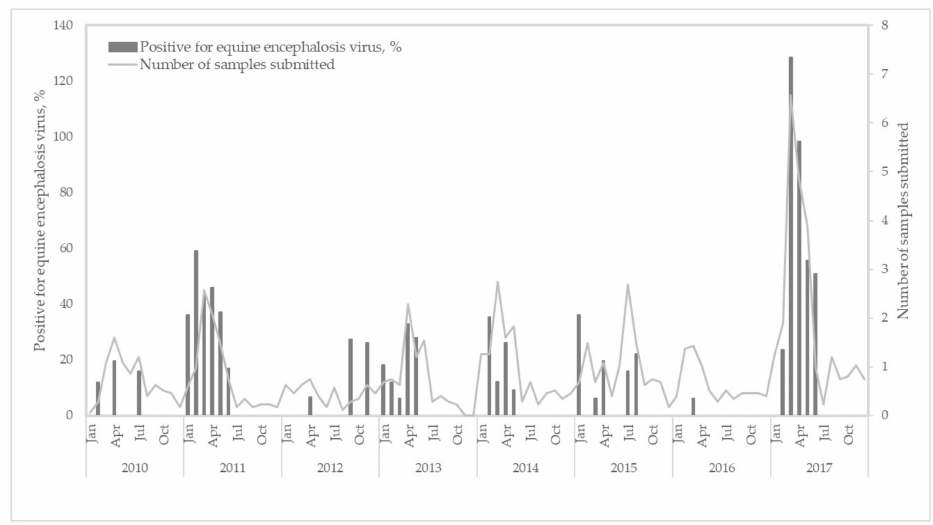
Figure 2. Seasonal detection of equine encephalosis virus-positive infections in horses in South Africa, 2010–2017. The left axis indicates the EEV positivity and the right axis the number of samples